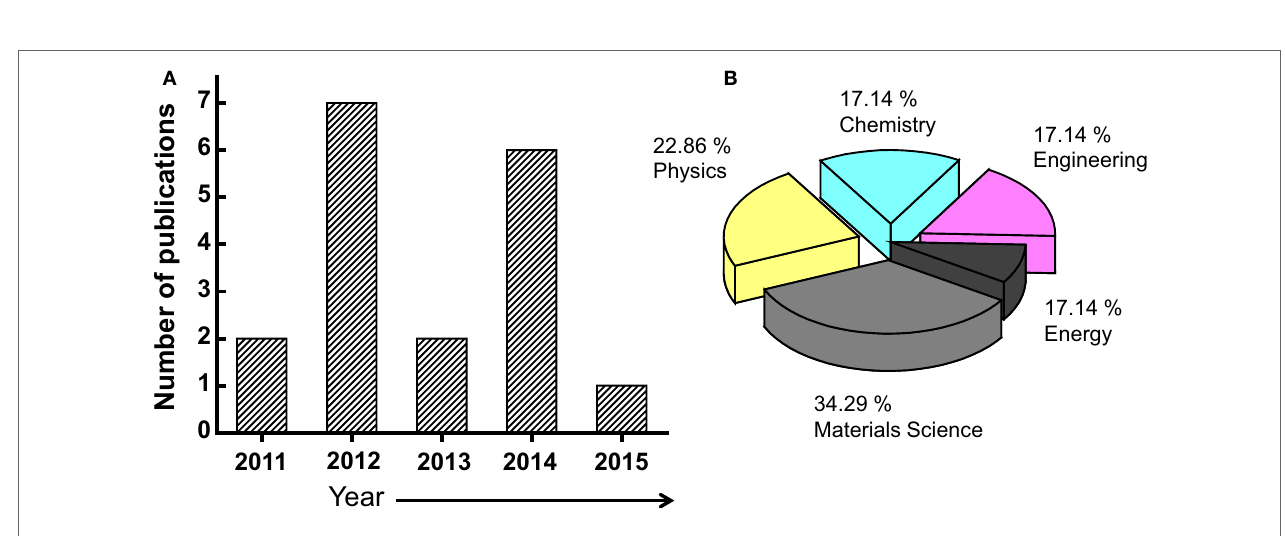
FiGURe 2 | (A) Number of the publications/year on the graphene materials. The inset is the distribution of the document type, where only 2.7% of the publications are related to a review work. (B) Distribution of the publications by subject